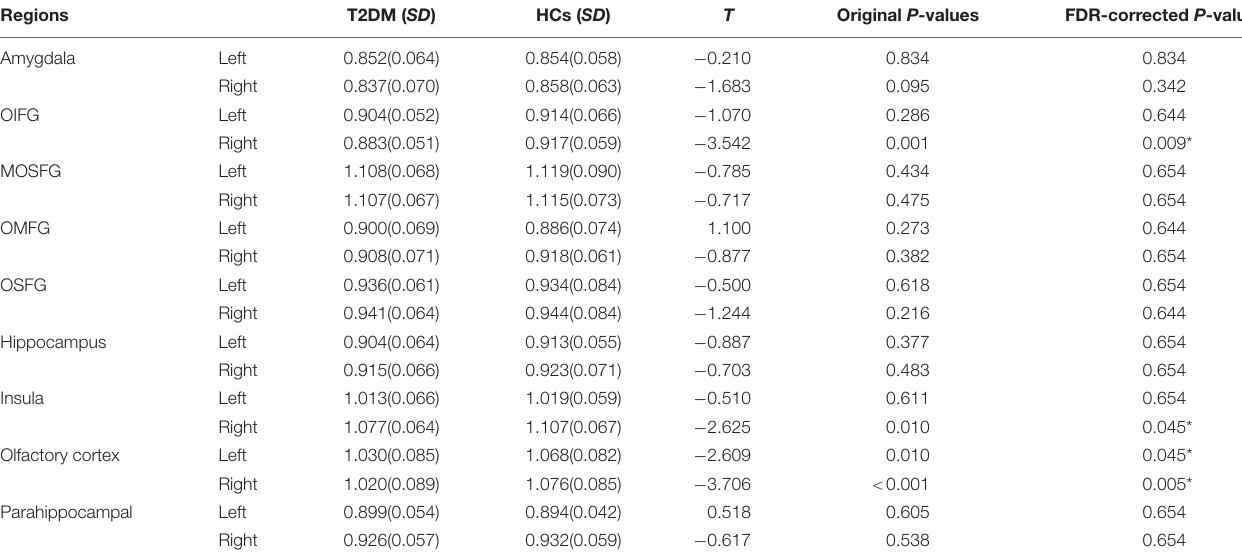
TABLE 3 | Comparison of cerebral blood flow (CBF) in olfactory-related brain areas between the T2DM and HC. Regions T2DM ( SD ) HCs ( SD ) T Original P- values FDR-corrected P -values Amygdala